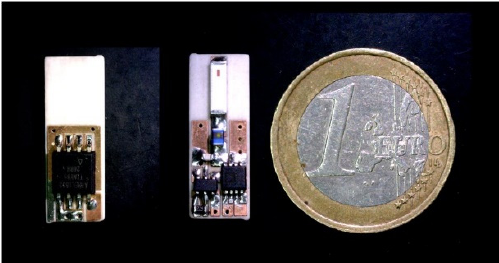
Figure 2. Photograph of LoRa bottom backscatter. Microcontroller and top layer with the RF switch and oscillator.